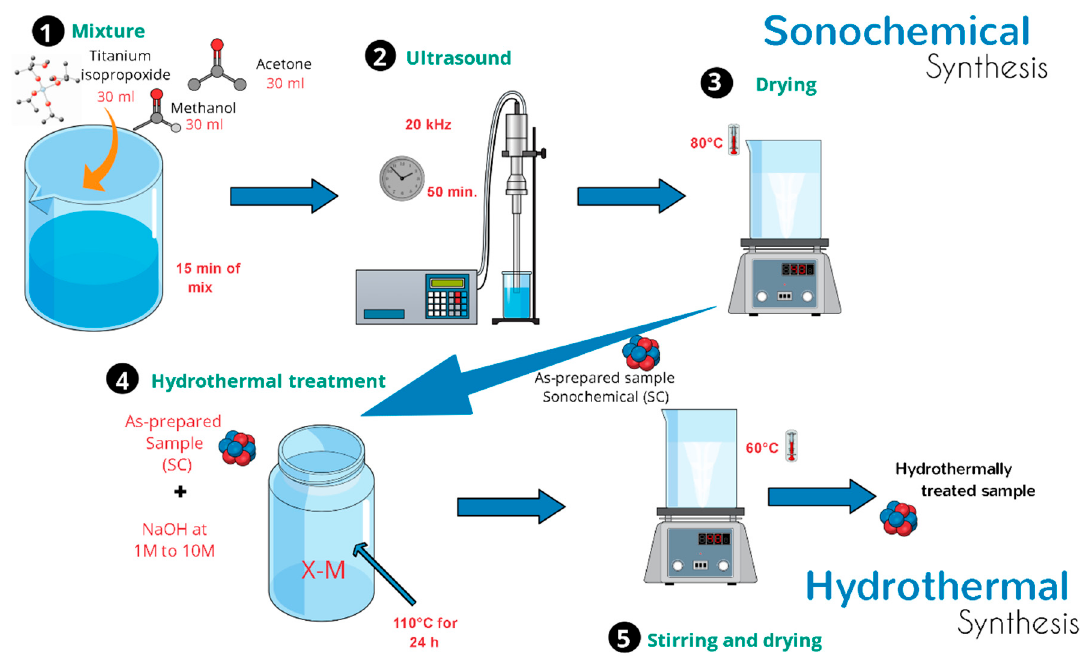
Figure 1. Schematic diagram of the synthesis process.